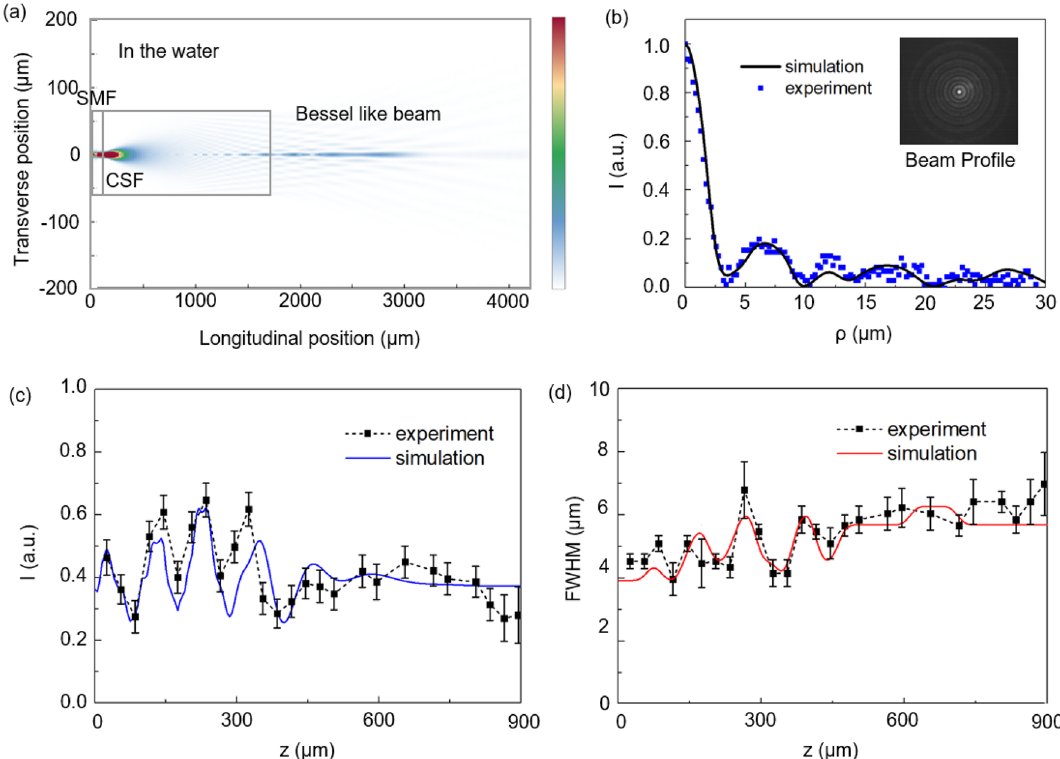
Figure 2. ( a ) BPM simulation of the proposed fiber-optic Bessel beam generator concatenating SMF and CSF. The axial beam intensity distribution in the water is plotted and next to the figure, its linear scale is shown in the color bar. From ( b ) to ( d ), we defined the axial position ‘z’ as the longitudinal distance measured from the end facet of CSF. ( b ) Transverse light intensity profile of the Bessel-like beam. The inset photograph is the measurements taken at z = 100 μm. ( c ) Longitudinal light intensity profile. Here we plotted the central peak intensity as a function of the axial position, z. ( d ) FWHM of the central peak as a function of z. The incident laser power was 340 mW at λ = 1063 nm.